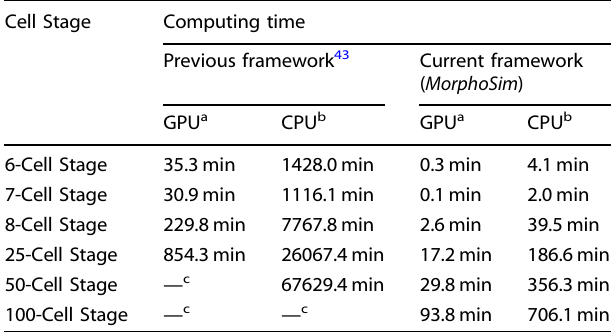
¼ 0 : 3 ´ δ t (cid:2) 1 and c